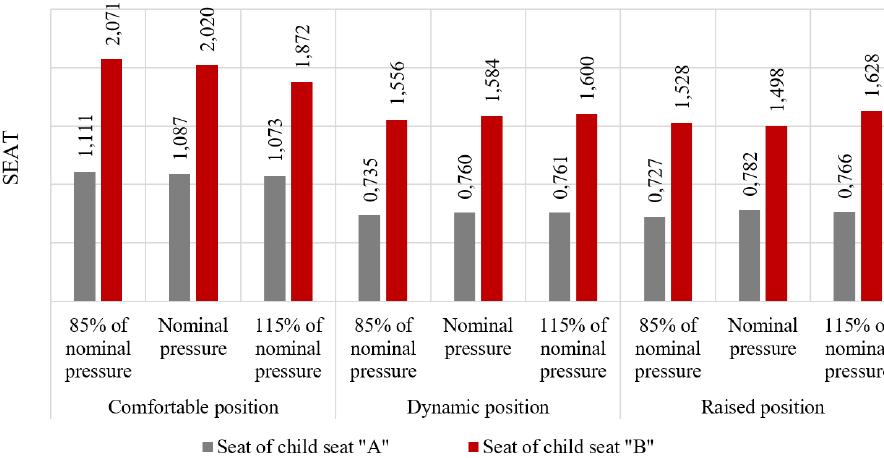
Figure 18: SEAT indicator on the seat of the tested child seats with a load of 10 kg